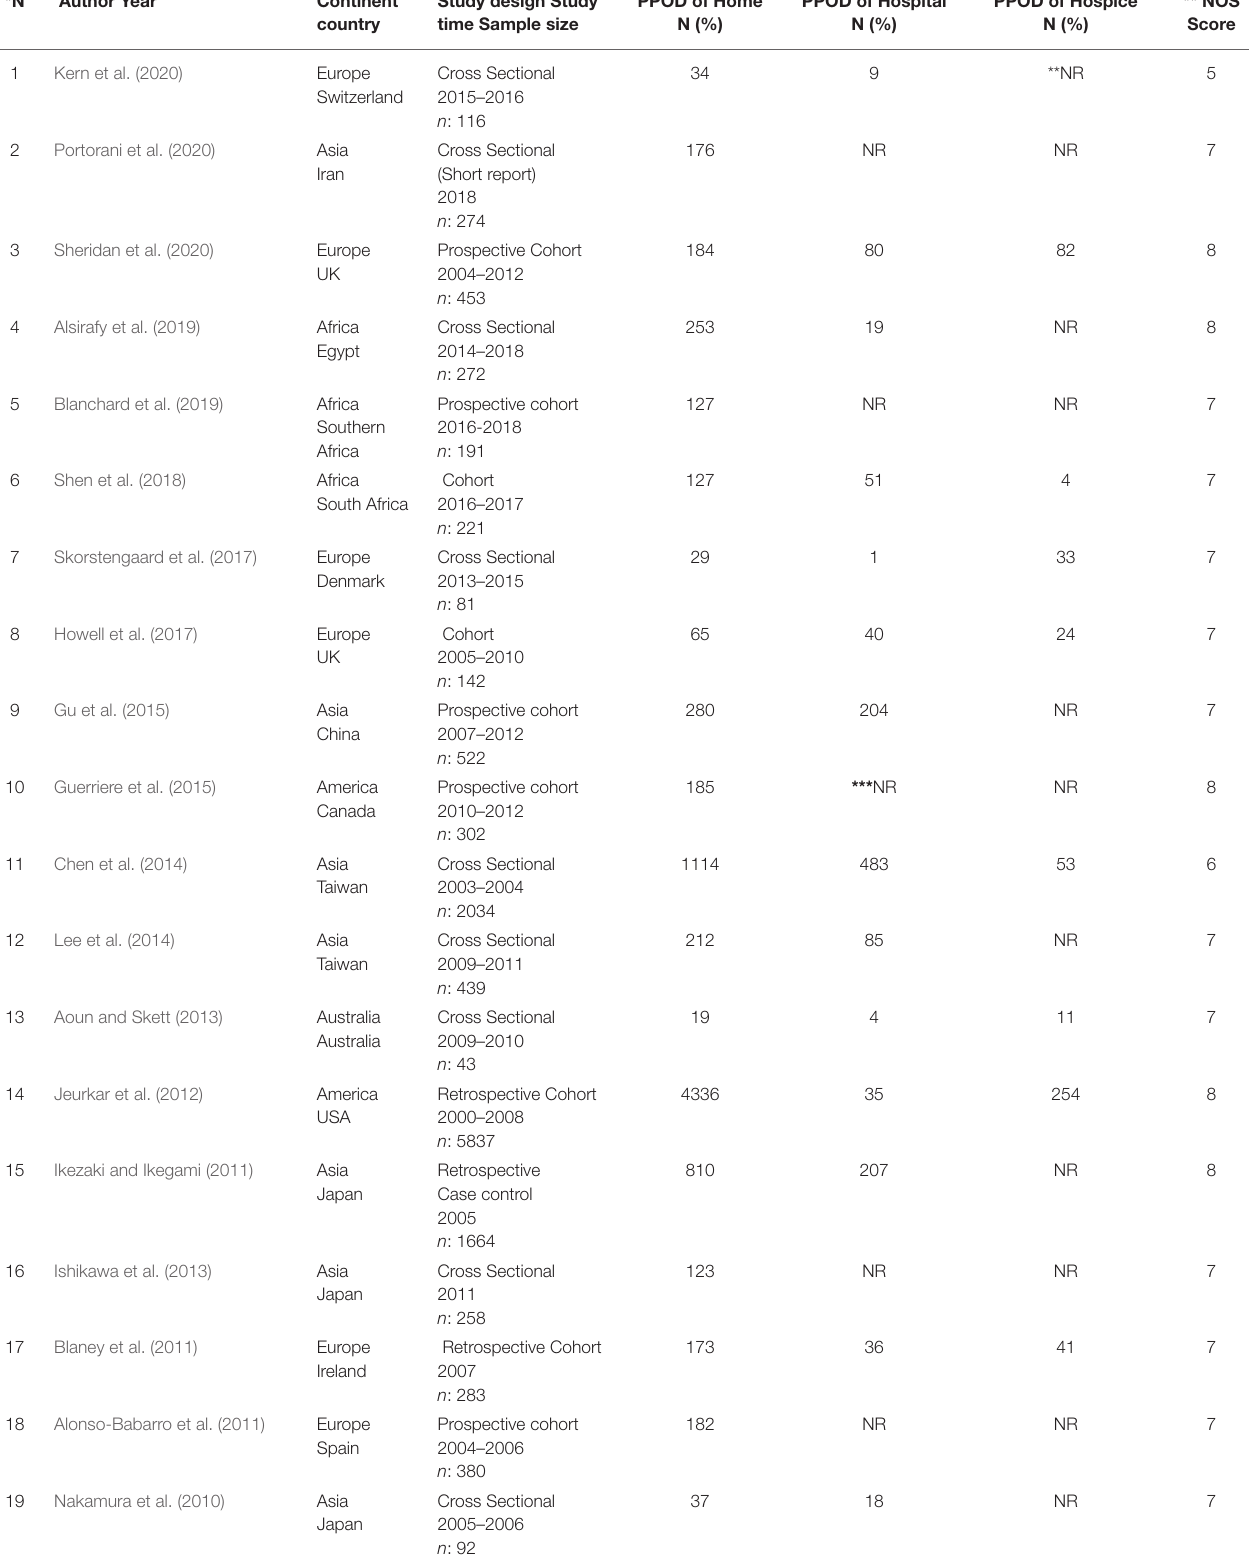
TABLE 2 | Characteristics and results of included